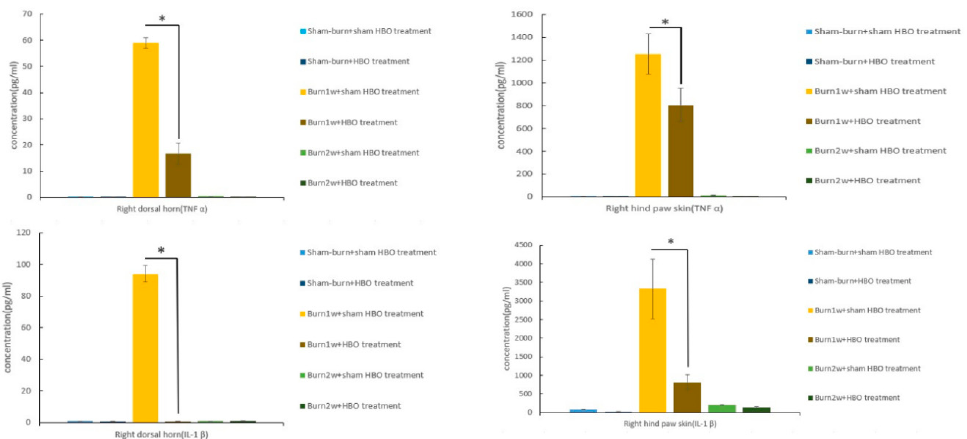
Figure 3. ELISA test. HBO treatment significantly inhibited the expression of the inflammatory proteins TNF- α and IL-1 β in the dorsal horn of the spinal cord and the right hind paw skin in the burn with one-week HBO treatment group compared with the burn with sham HBO treatment group. * p < 0.05.